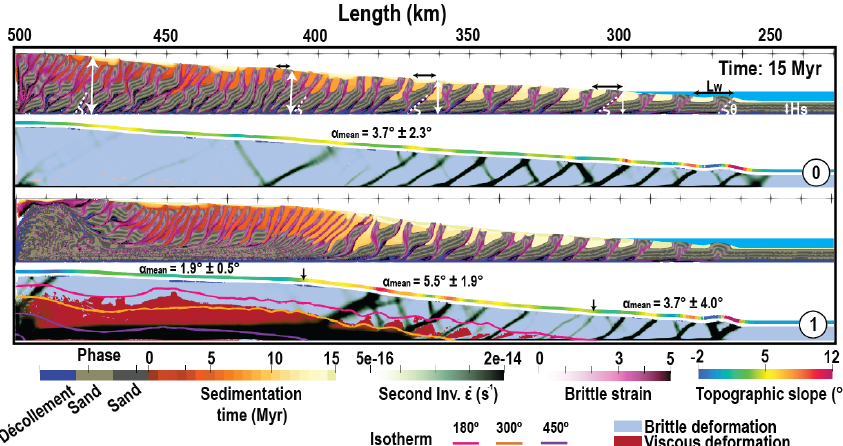
Figure 2. Model M0 : without temperature compared to model M1 : the same experiment with temperature-dependent rheologies, both after 15Myr evolution. The finite strain and the current state and strain rate are shown for basal frictional angle ( φ b = 5 ◦ ) and internal friction angle dropping from 25 to 10 ◦ with strain. The yellowish-brown color illustrates syn-tectonic sedimentation in the form of piggyback basins which represent a given age that corresponds to the time of deposition. Where the material is yielding plastically is in blue or where it deforms viscously is in red with the onset of 180, 300, and 450 ◦ C isotherms. Black arrows display decreasing thrust space towards the backstop and white arrows show increasing sequence thickness and inclination angle θ . The local topographic slope with a color code shown at the top of the slice is affected by temperature and frictional properties, 1:1